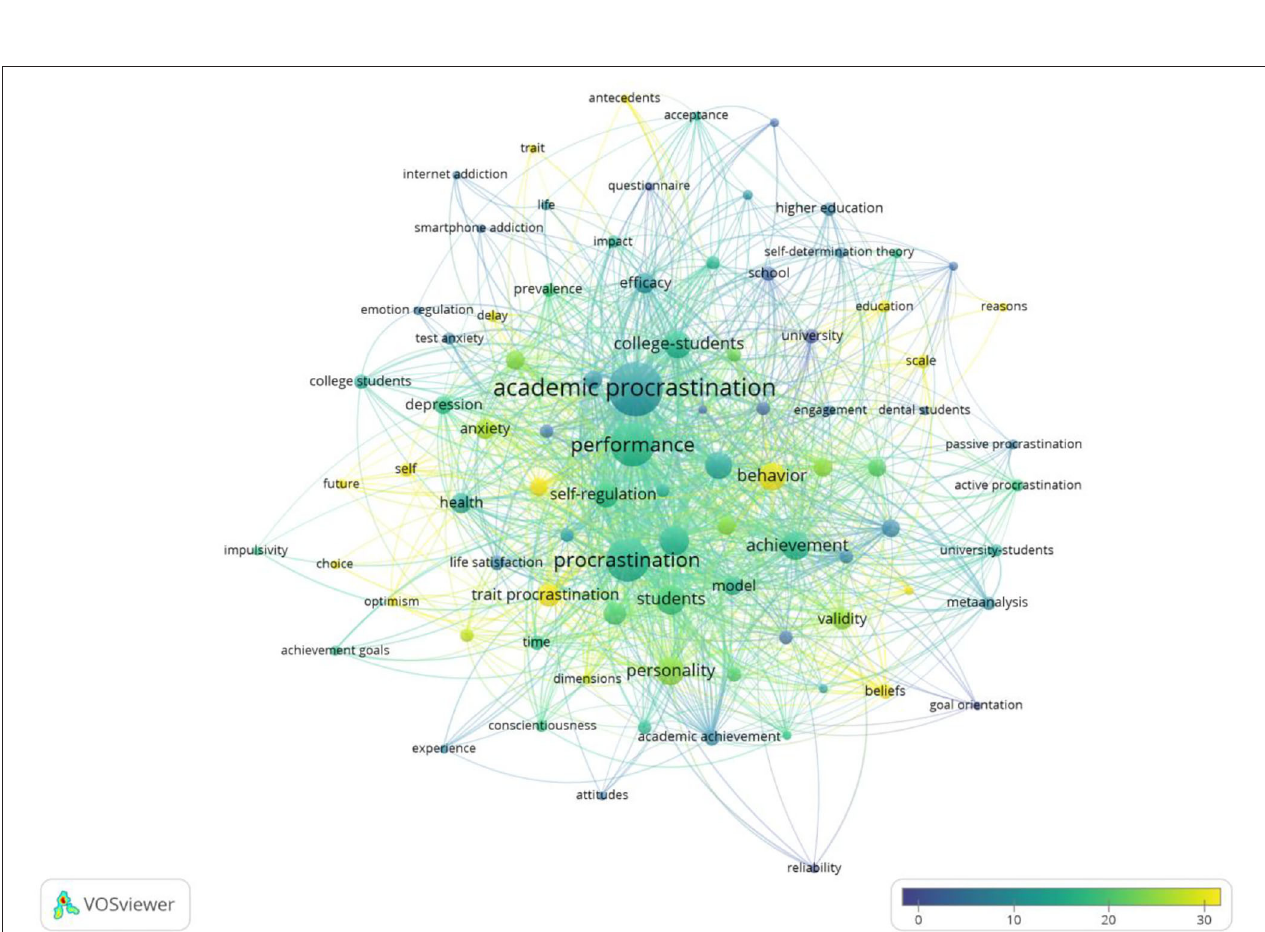
FIGURE 7 | Overlay visualization based on procrastination link-weights and citation scores.